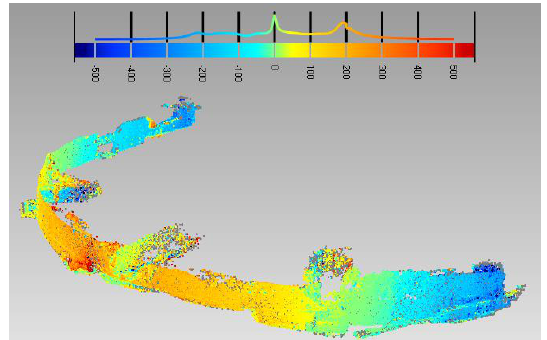
Figure 5. Comparison [mm] between two point clouds of the wall GG’ (Figure 1a), generated respectively with bundle adjustment solutions in free network and with 3 GCPs. Strong deformations are clearly visible at the end of the image block for the free network solution.